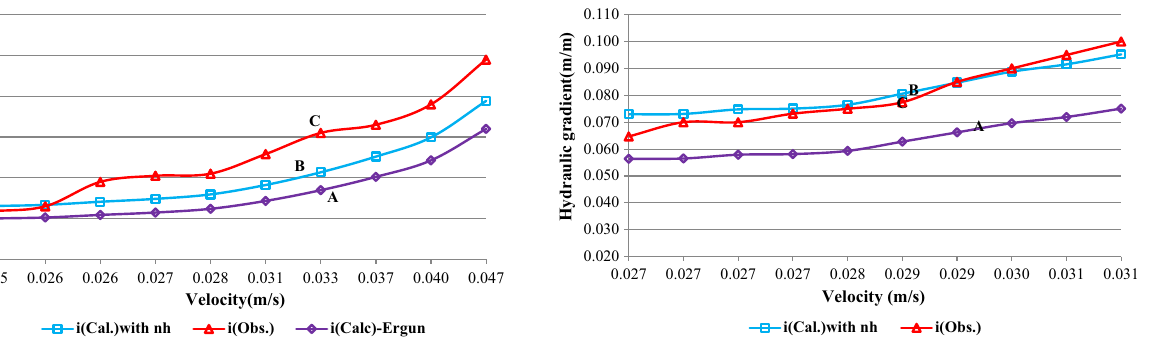
Fig. 8 Comparing plots of hydraulic gradient versus velocity for CGM1 series. Result is after 480 s of run start. Curve “A” shows vari- ations of ( i ) versus ( V ) based on common porosity concept, curve “B” shows variations of ( i ) versus ( V ) based on hydraulic porosity con- cept, curve “C” shows variations of ( i ) versus ( V ) based on actual model observations